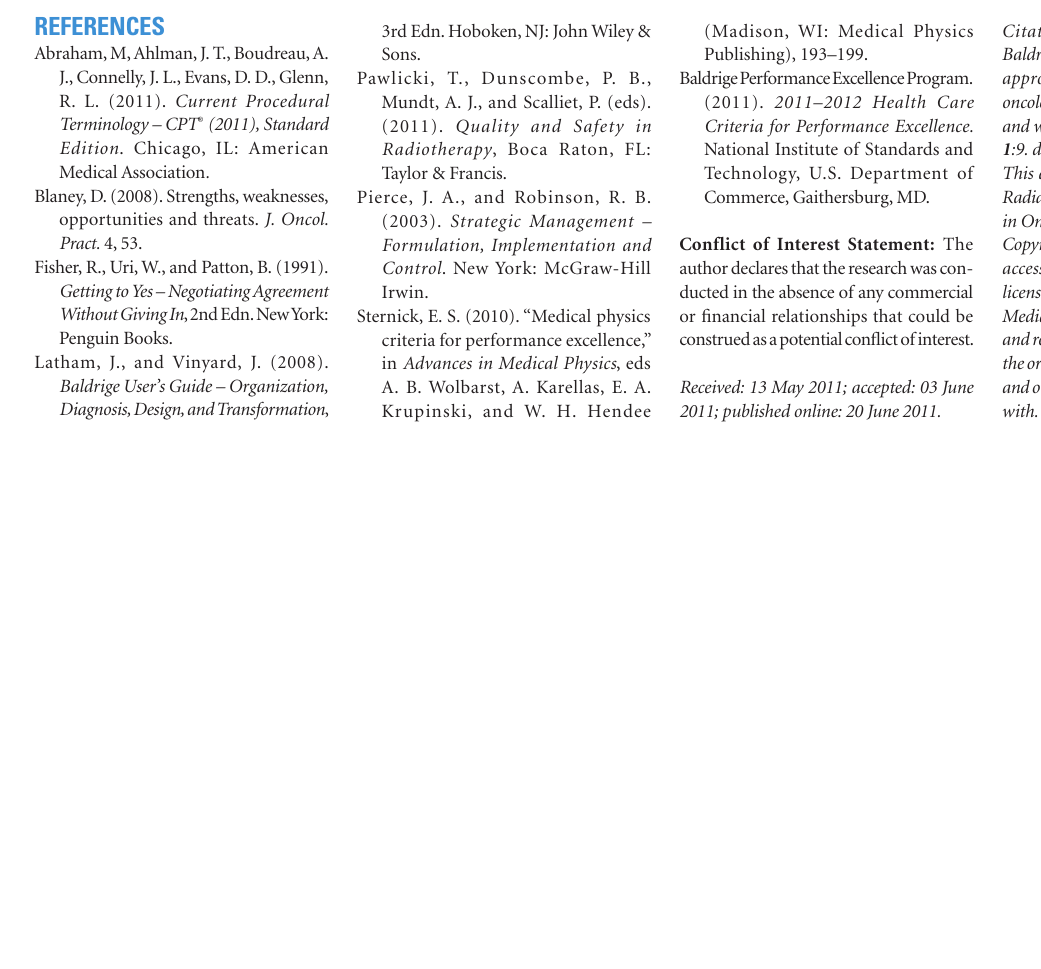
Table 4 ). Approaches and outcomes that meet the general require- ments of a particular Category are characterized by a score of 50%. Accomplishments determined to be inferior to or exceeding that ranking are scored accordingly. Final scores are calculated using the product of defined percentiles and the available point value assignments ( Table 1